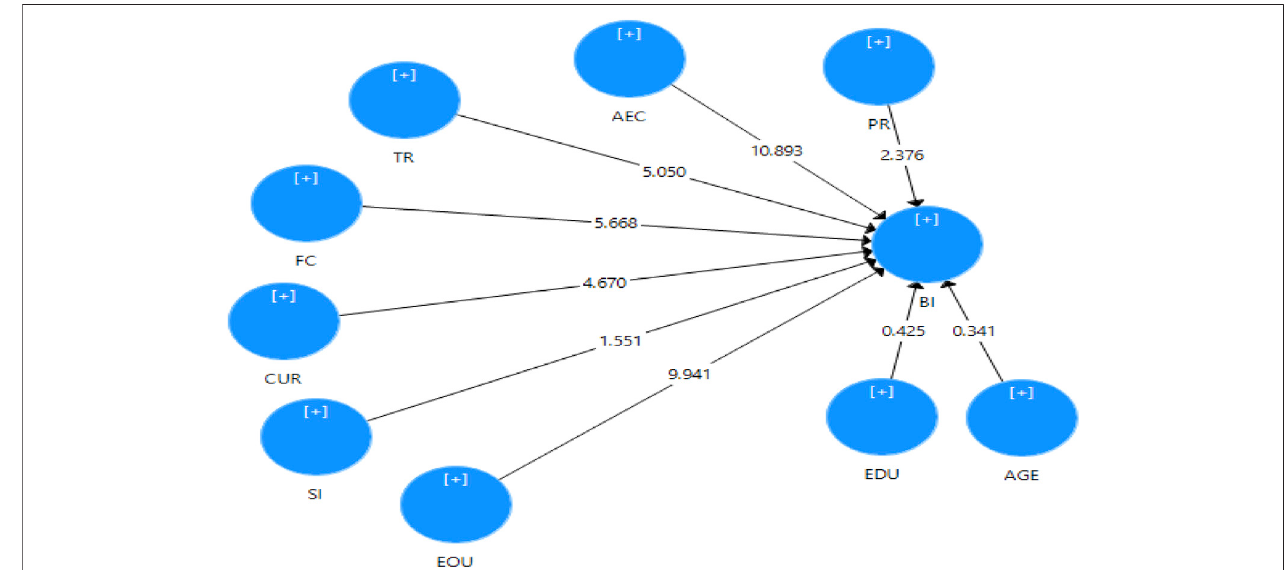
FIGURE 3 | Path model (M1).